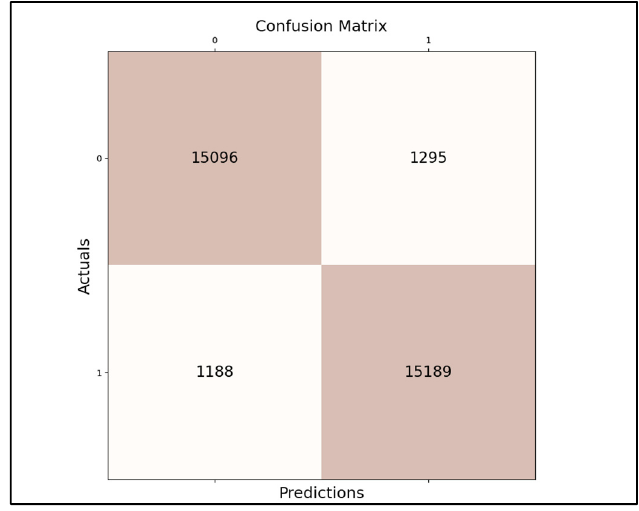
Figure 8. Confusion matrix reached with the best model.